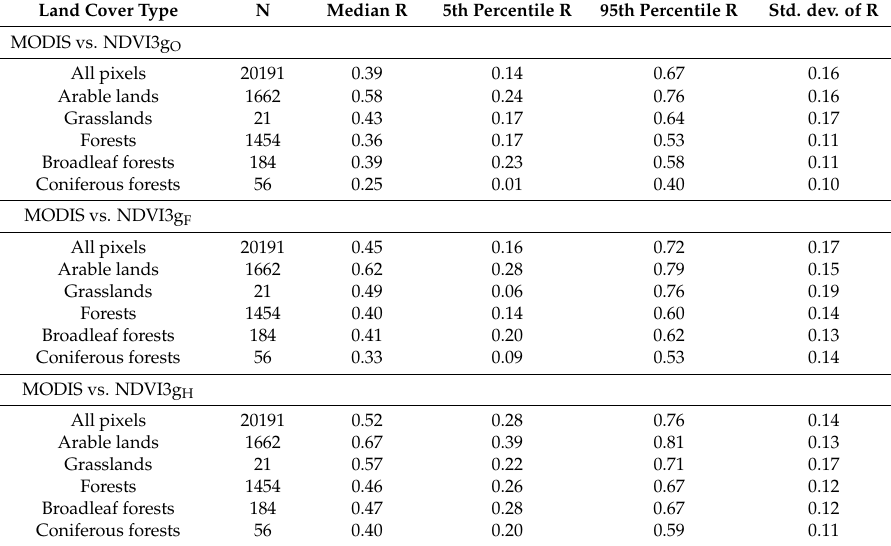
Table 1. Statistics of the R values between the anomaly fields of NDVI MODIS and the NDV3g O , NDV3g F and NDV3g H datasets during the second half of April - the first part of September period, for all vegetated pixels and for the different land cover types. (Std. dev. of R is the standard deviation of R values).